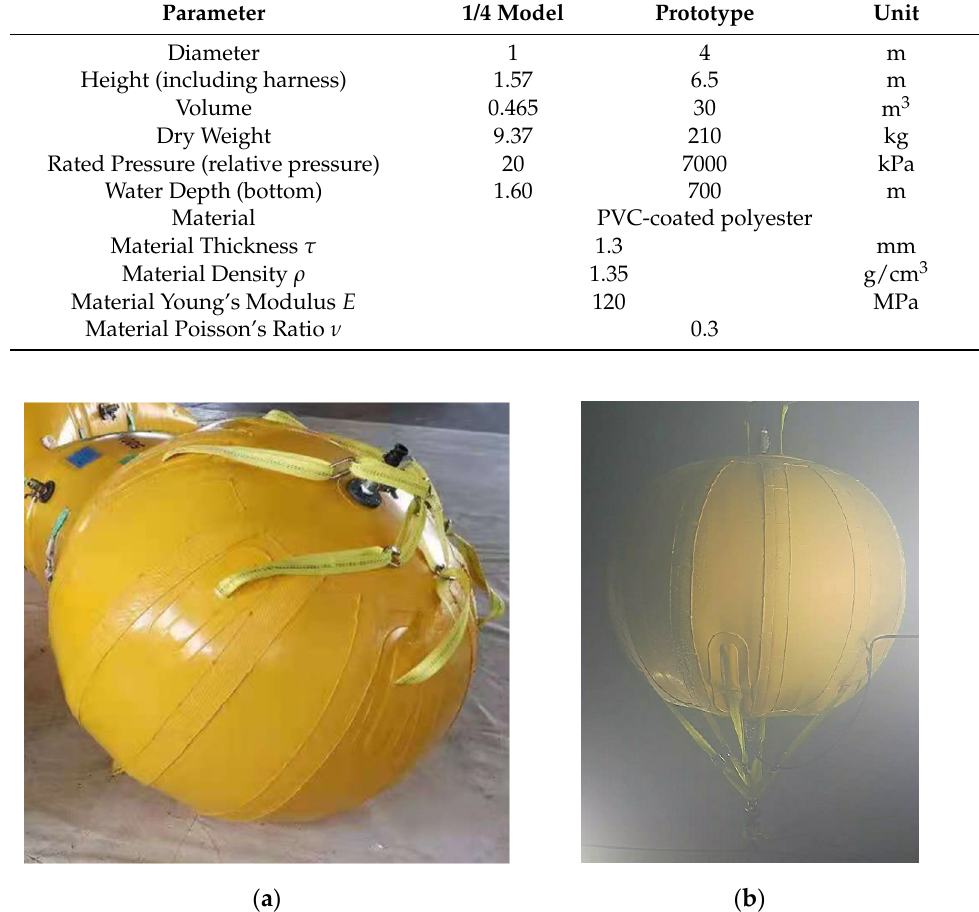
Figure 1. ( a ) Bo tt om straps and port of the fi lled 1/4 model; ( b ) photo captured via camera #2 at the Figure 1. ( a ) Bottom straps and port of the filled 1/4 model; ( b ) photo captured via camera #2 at the same depth as the testing model center. same depth as the testing model